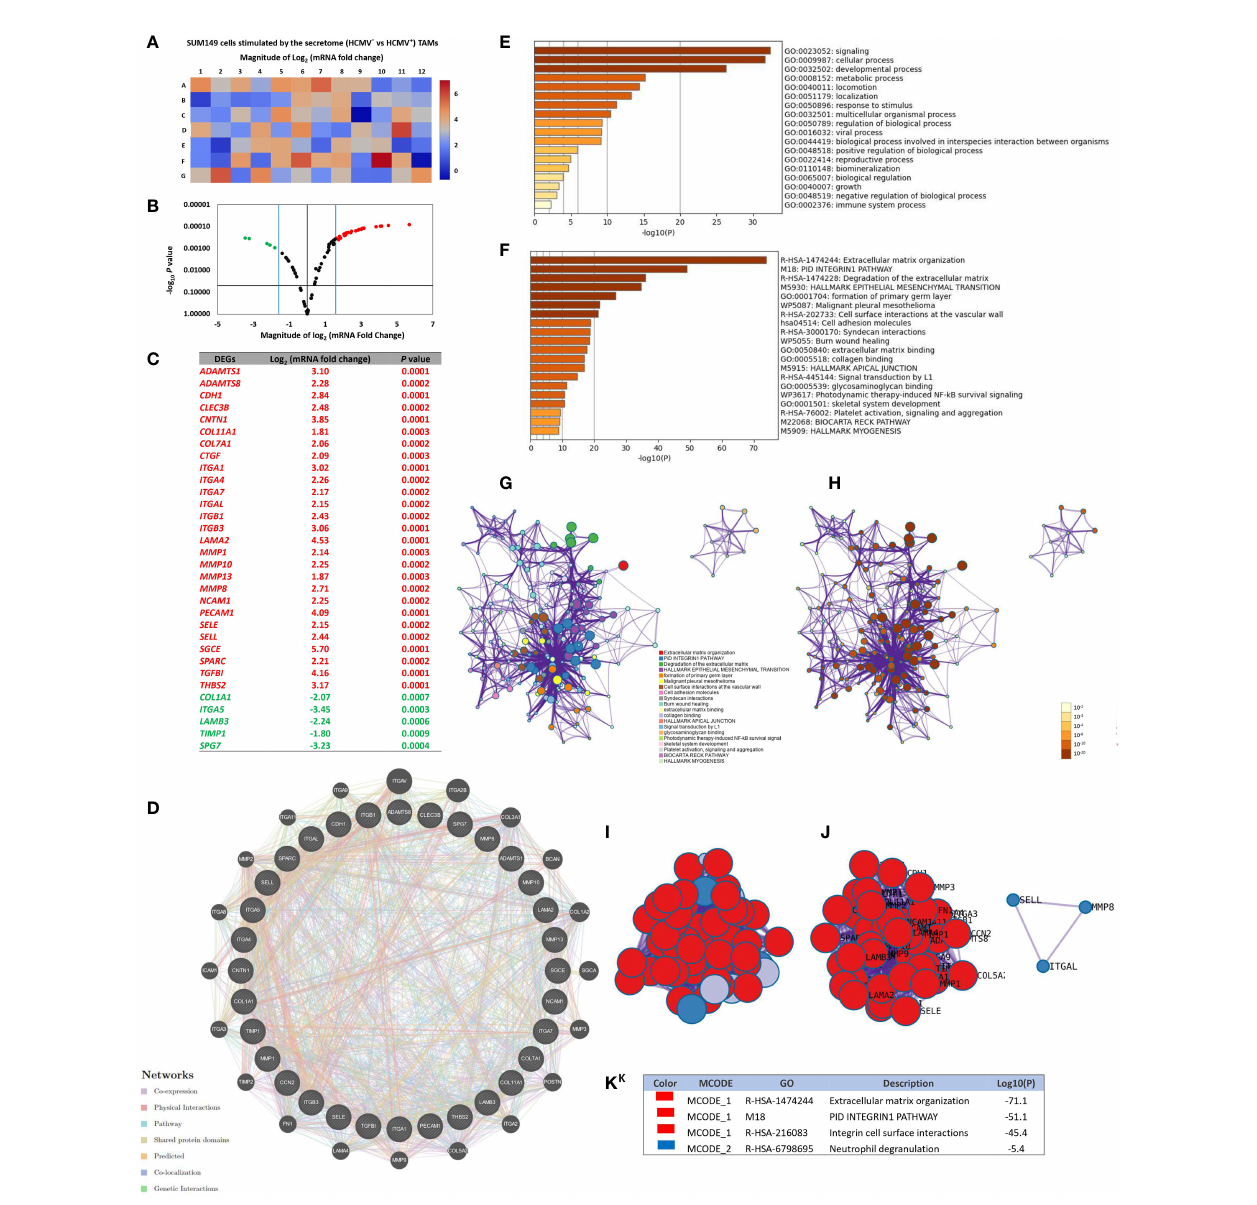
FIGURE 4 | Up- and downregulated extracellular matrix and cell adhesion genes of SUM149 cells stimulated by the secretome of HCMV + polarized TAMs versus HCMV + polarized TAMs. (A, B) Heat map and volcano plot showing signi fi cant up- and downregulated genes in SUM149 cells stimulated by the secretome of HCMV + polarized TAMs compared to HCMV + polarized TAMs. (C) Table showing the Log2 mRNA fold change and signi fi cant P values of up- and downregulated genes in SUM149 cells stimulated by the secretome of HCMV + polarized TAMs versus HCMV + polarized TAMs. (D) Gene-gene interaction network of different expressed extracellular matrix and cell adhesion molecule genes and their neighboring genes. Each node represents a gene, and the size of which represents the strength of the interaction. (E) Bar graph of the top-level Gene Ontology biological processes, with P -values. (F) Bar graph of enriched terms across input gene lists, with P -values. (G, H) Network of enriched terms: colored by cluster ID, where nodes that share the same cluster ID are typically close to each other; colored by p- value, where terms containing more genes tend to have a more signi fi cant P -value. (I, J) Protein-protein interaction network and MCODE components identi fi ed in the gene list. (K) Table showed the functional analysis of MCODE1 and MCODE2